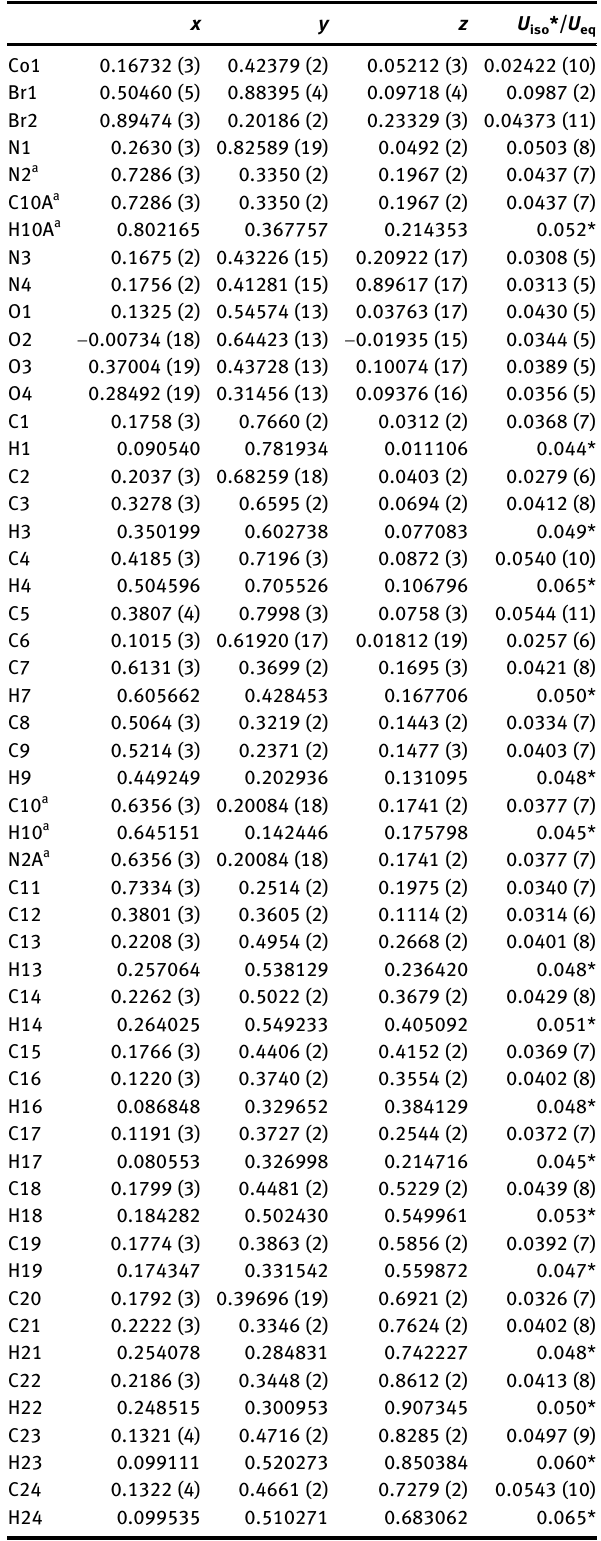
Table  : Fractional atomic coordinates and isotropic or equivalent isotropic displacement parameters (Å 